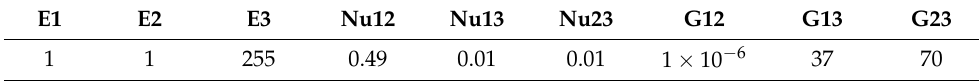
Table A4. Al honeycomb stiffness properties [MPa].